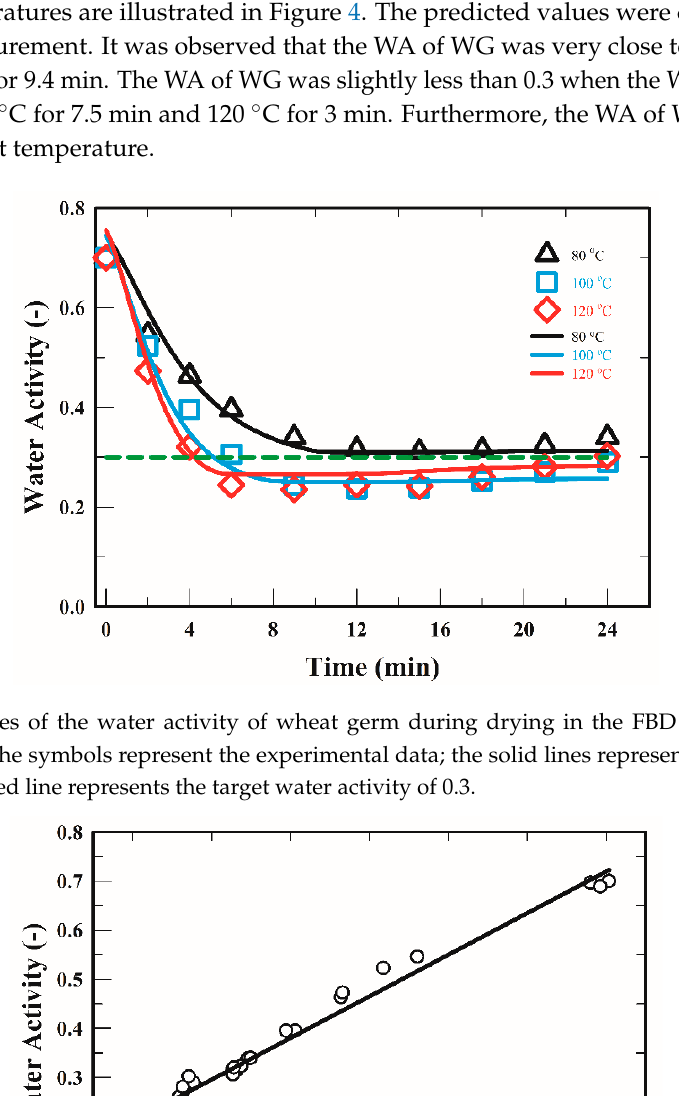
Figure 5. The relationship between the water activity and moisture content of wheat germ. The symbols represent the experimental data; the solid line is the regression line.